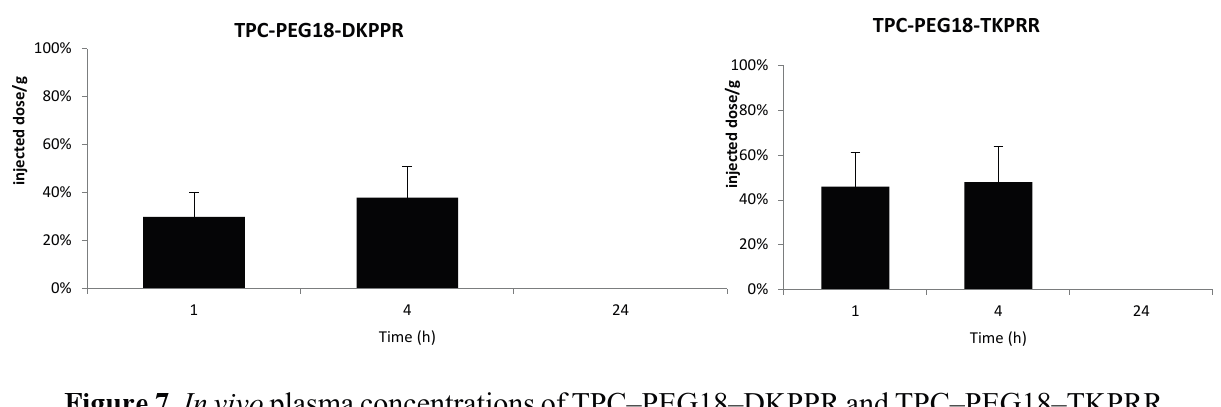
Figure 7. In vivo plasma concentrations of TPC–PEG18–DKPPR and